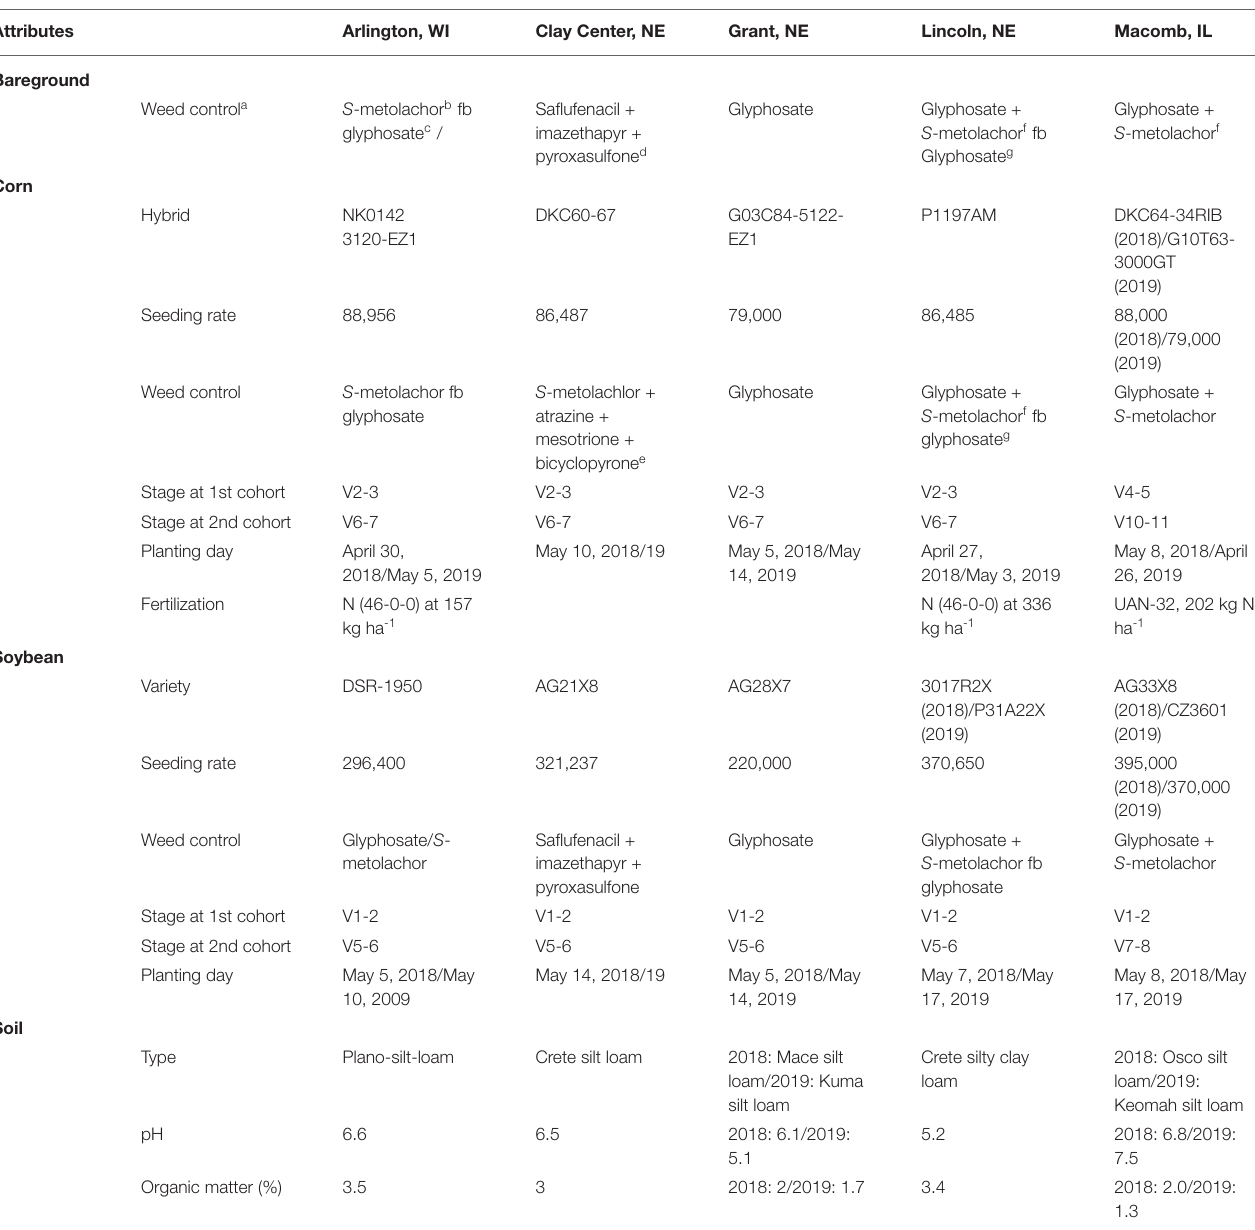
TABLE 1 | Field study attributes from Arlington, WI, Clay Center, NE, Grant, NE, Lincoln, NE, and Macomb, IL.